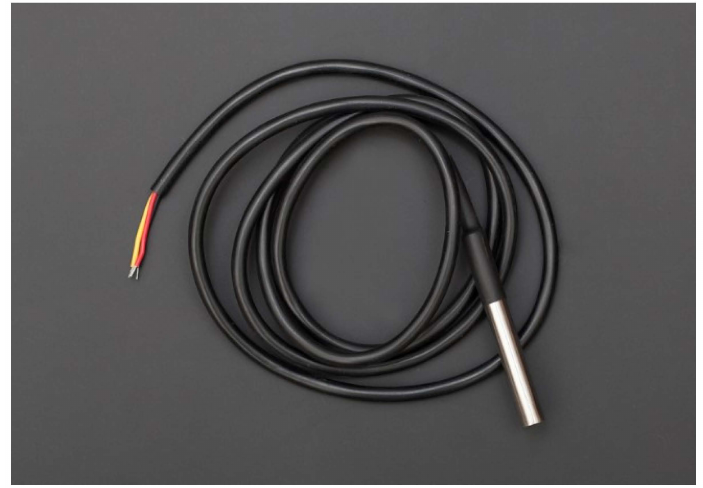
Figure 4. DFRobot Waterproof DS18B20 Digital Temperature